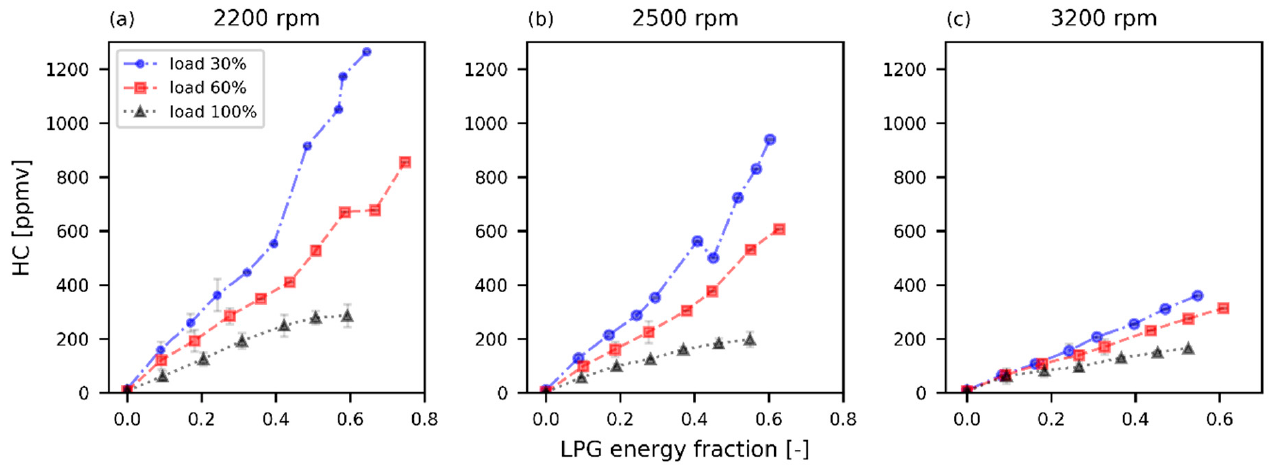
Figure 7. HC emissions v/s LPG energy fraction at ( a ) 2200 rpm, ( b ) 2500 rpm, and ( c ) 3200 rpm.